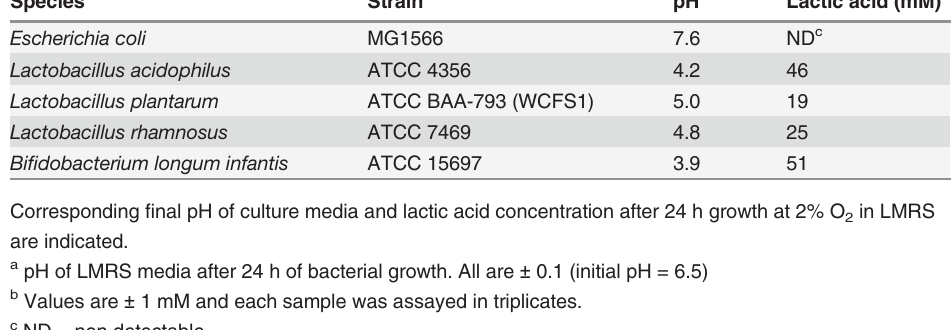
Table 1. Bacterial species and strains used in this study. Species Strain pH a Lactic acid (mM) b